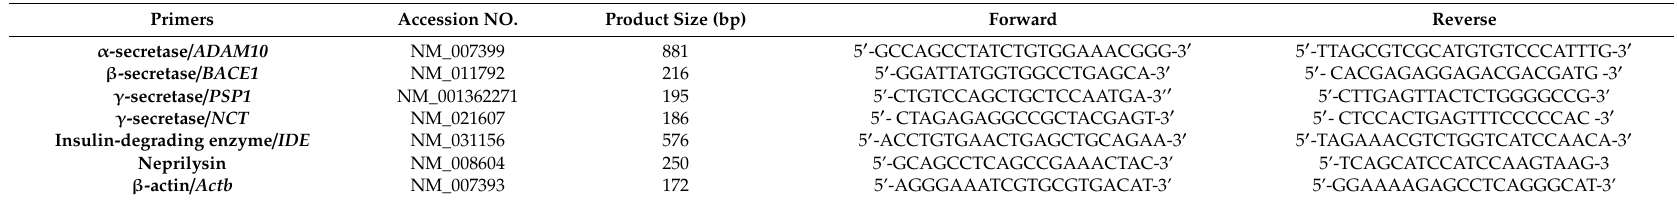
Table 1. Primer sequences used for